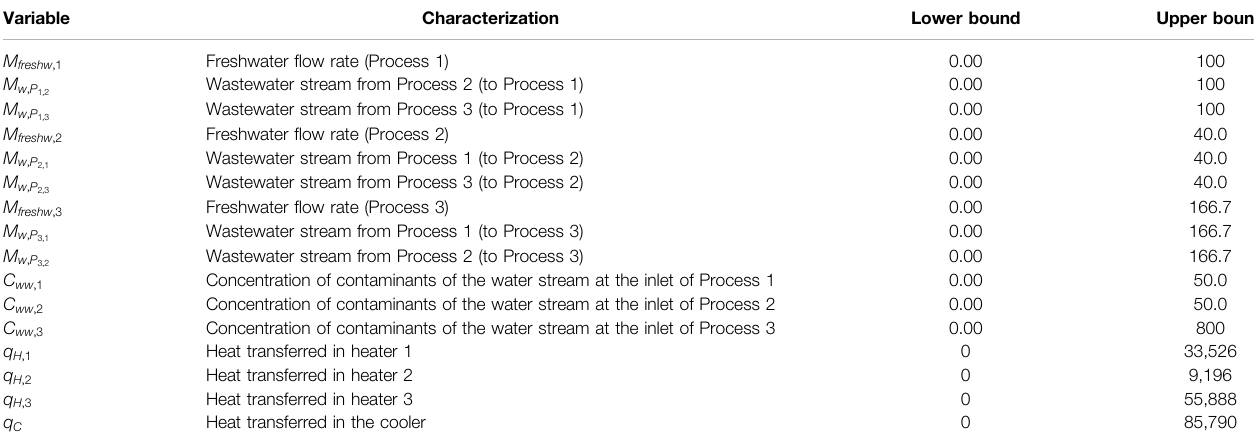
TABLE 13 | Characterization of decision variables of the MOP model. Variable